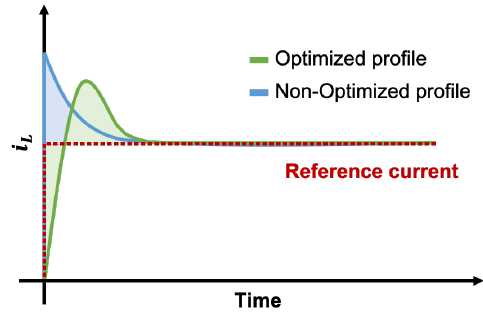
Figure 4. Example of inductor current profile